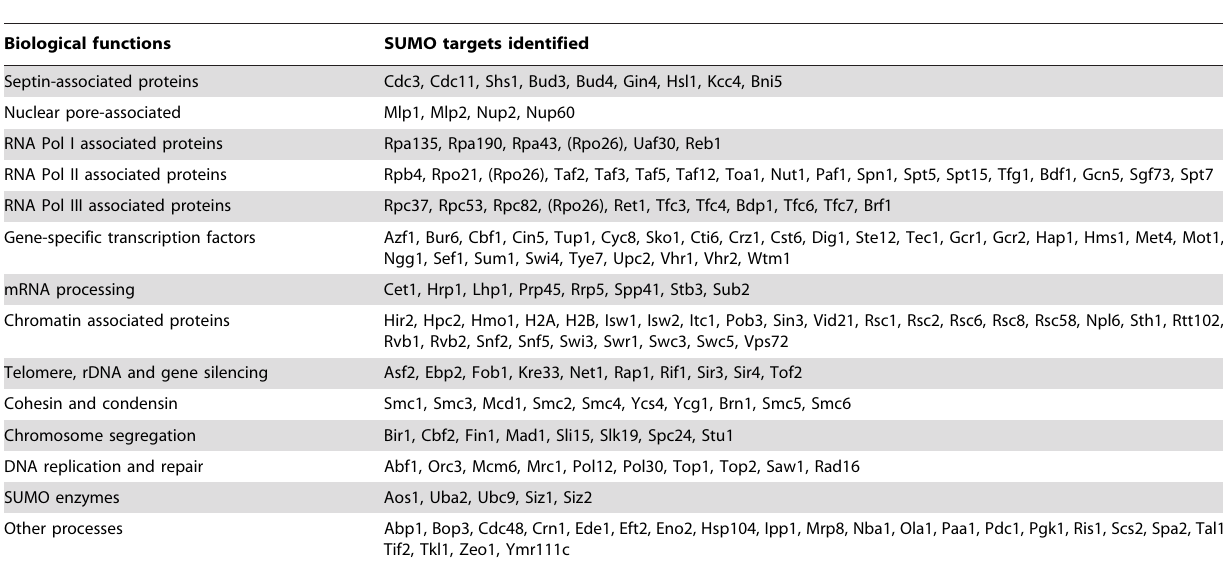
Table 2. A summary of 176 sumoylated proteins identified from two replicate MS experiments (see text for details).